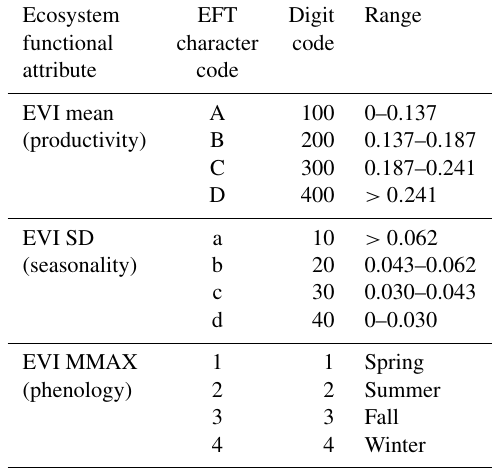
Table 1. Ecosystem Functional Attribute (EFA) ranges used for the identification of Ecosystem Functional Types (EFTs) in the Sierra Nevada Biosphere Reserve. For EVI_DMAX, the four in- tervals agree with the four seasons of the year. For EVI_mean and EVI_sSD, we extracted the first, second, and third quartiles for each year and then calculated the interannual mean of each quartile (their average over the 18-year period). The values of both EVI_mean and EVI_sSD are multiplied by 10000 in the .TIF files to save disk space. Ecosystem EFT